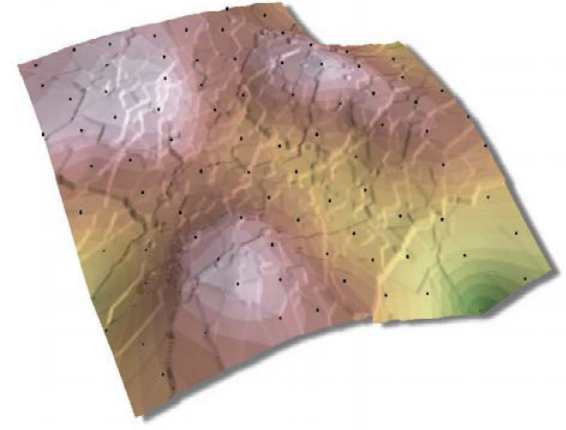
Figure 6. Example of Kriging( ArcUser,